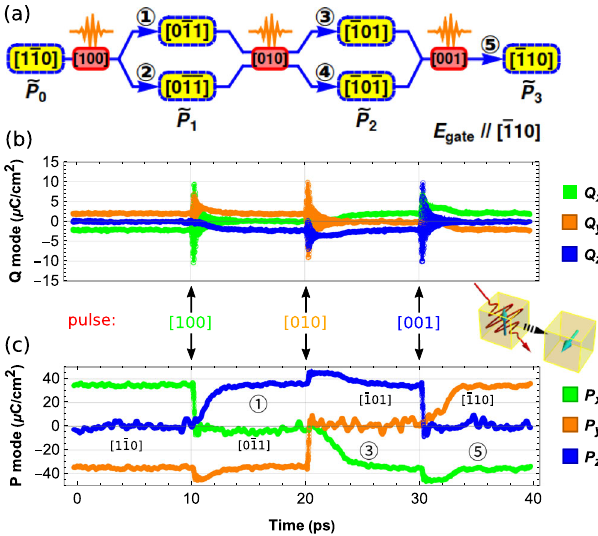
Fig. 3 Deterministic full-reversal strategy. a Protocol of the three-pulse reversal process; the yellow background boxes are for the initial and excited polarization phases and the pink background boxes are used to indicate the laser pulses that are along x , y , and z axes; The labels of the phases e P is de fi ned as P + Q to indicate the total polarization. The blue arrows are used to indicate the phase transition channels after the laser pulses. Responses of the Q ( b ) and P modes ( c ) excited by a sequence of three “ 200fs-18THz ” pulses activated at 10, 20, and 30 ps and having their polarized direction along [100], [010], and [011] directions, respectively. For each of